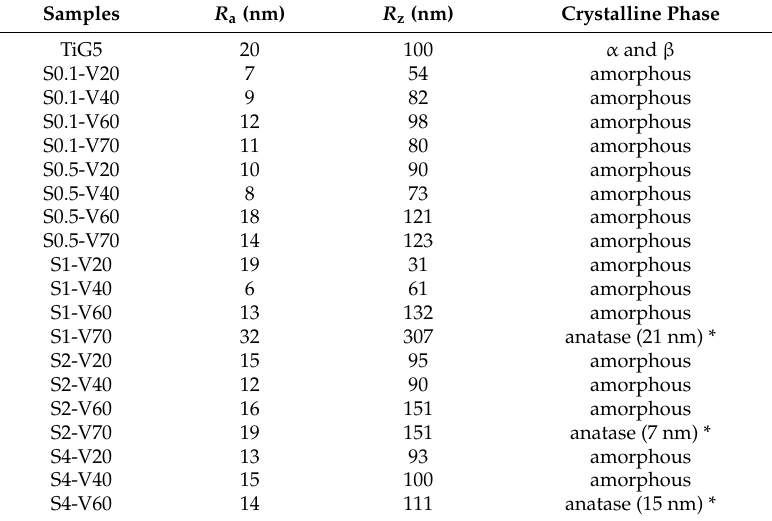
Table 1. Roughness ( R a and R z ) and crystalline phases of the coatings.